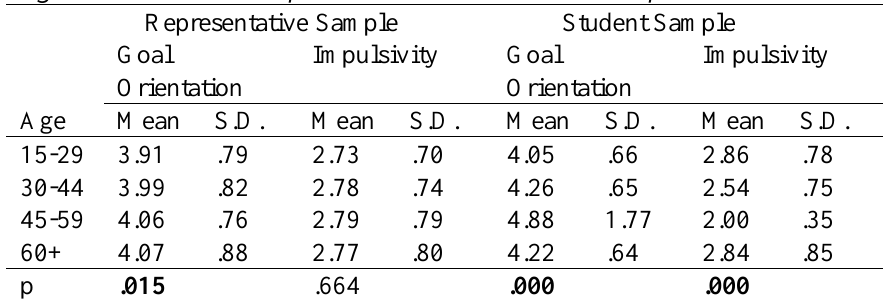
Table 5 Age differences in the representative and the student samples Representative